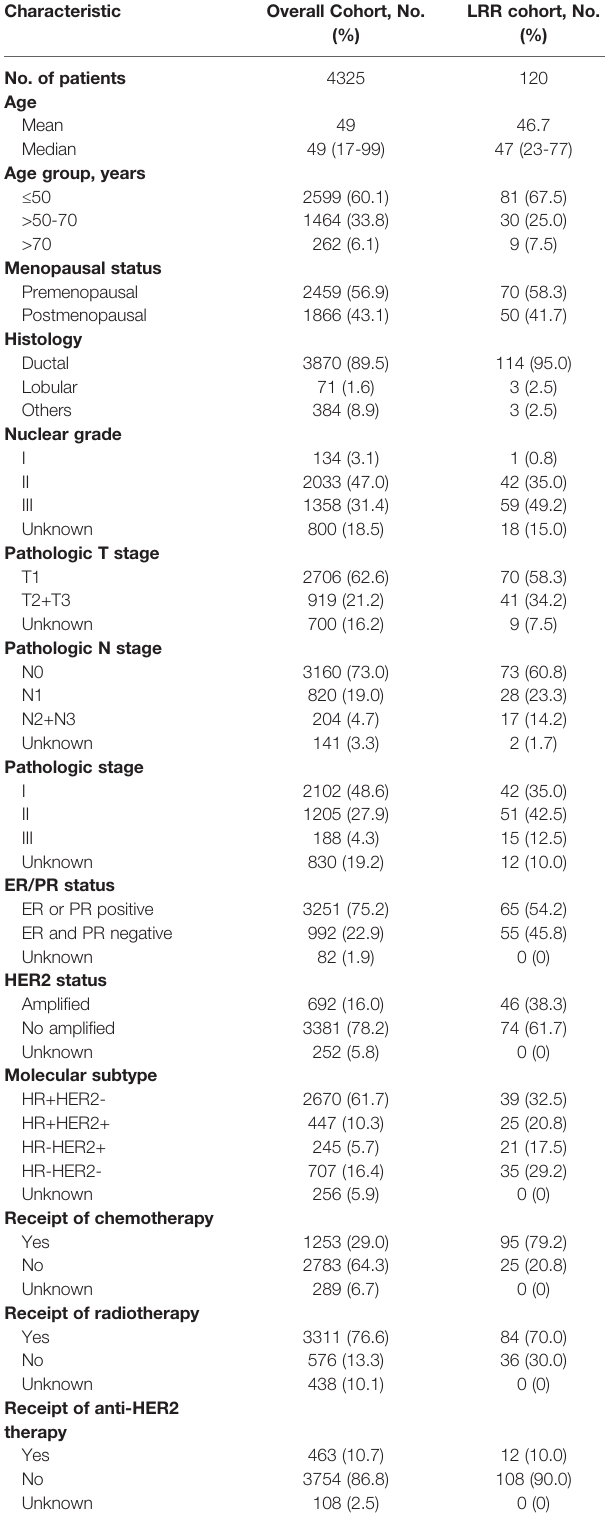
TABLE 1 | Baseline patient and treatment